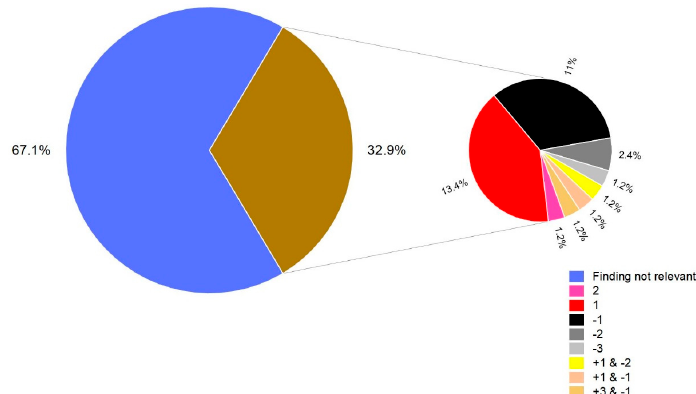
Figure 5. Relevance of A2 in 68 Ga-PSMA-PET/CT in PCa patients. In 27 patients (33%), there was a difference between A1 and A2 and thus relevance of the findings of the biphasic acquisition (left pie chart). In the right pie chart, the cases are divided proportionally according to the differences between A1 and A2.